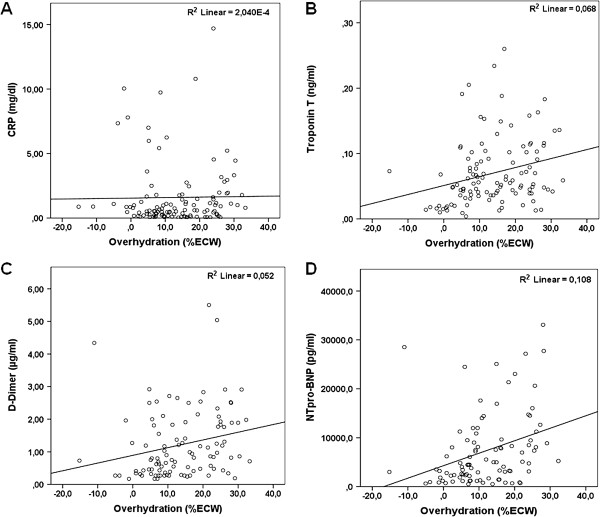
Relationship between fluid overload and markers representing inflammatory processes and cardiac strain markers. (A) C-reactive protein (cases >15 mg/dl excluded, n = 1), (B) D-Dimer (cases >7.5 μg/ml excluded, n = 3), (C) troponin T (cases >0.45 ng/ml excluded, n = 4) and (D) NT-proBNP (cases >35,000 pg/ml excluded due to assay incapacity, n = 26).